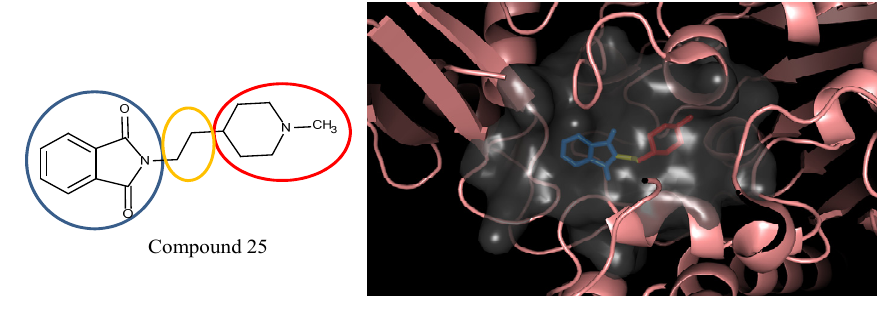
Figure 7. The divided Compound 25 of E2020 series. The ellipsoids define the portion of the compound that interact with the AChE binding site –the peripheral site (blue ellipsoid and sticks; fragment 1) and catalytic site (red ellipsoid and sticks; fragment 2)—while the linker is denoted with the orange ellipsoid. The cavity of AChE is depicted as a gray surface with a bound inhibitor